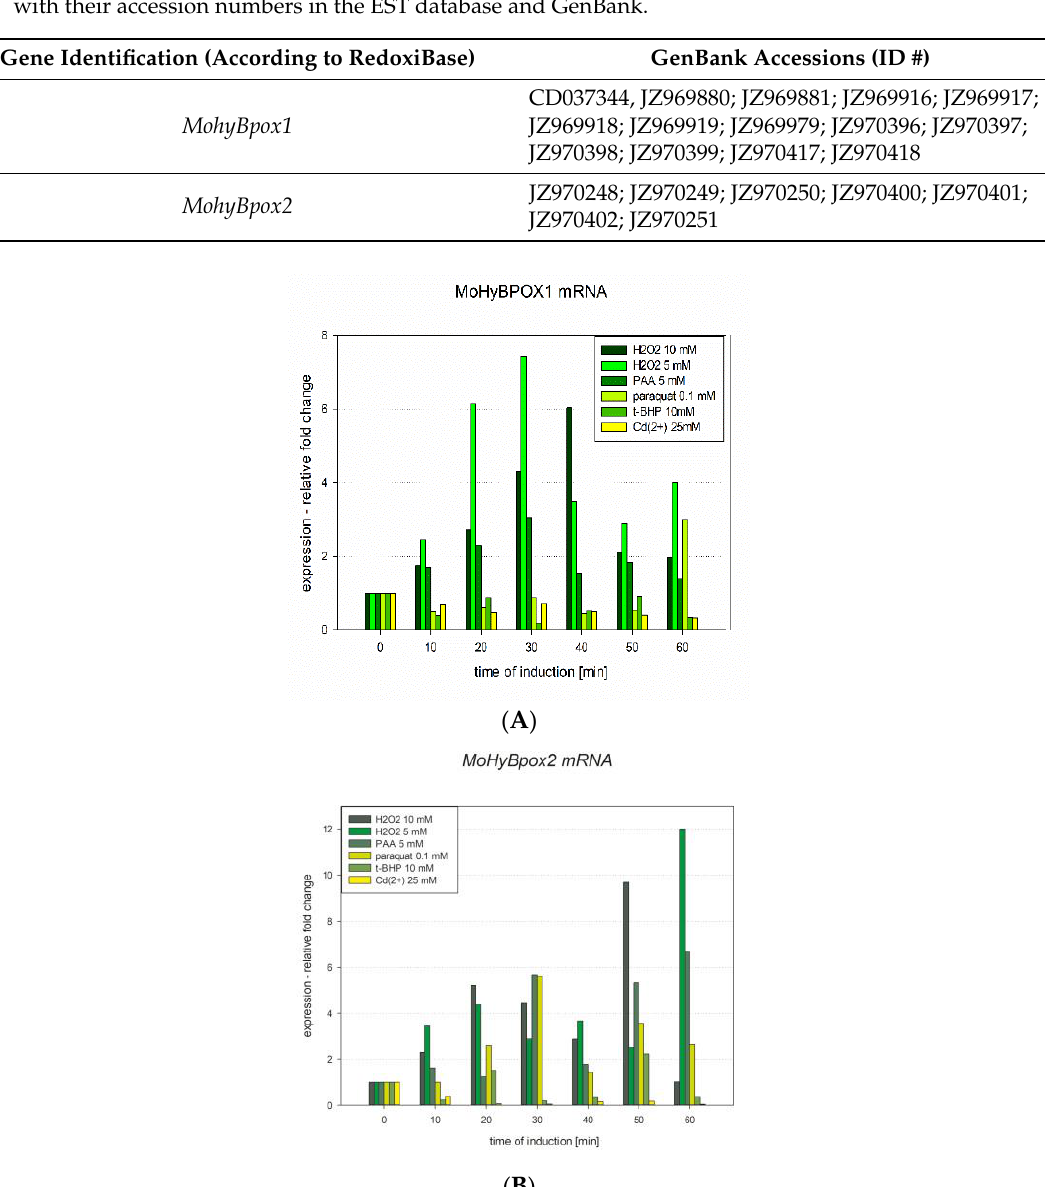
Table 1. The overview on all sequenced RT-PCR products for hyBpox genes from Magnaporthe oryzae with their accession numbers in the EST database and GenBank.